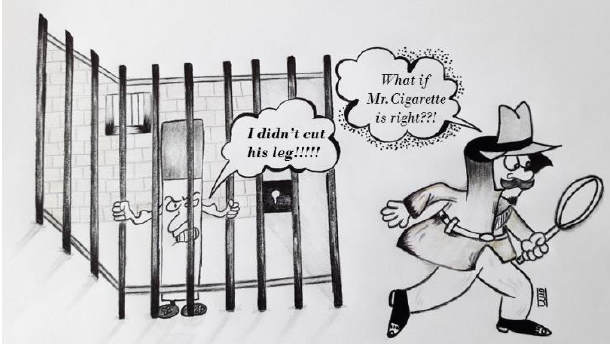
Figure 3. Although smoking is a strong factor in TAO development and prognosis, it appears that it is not the main aetiology of